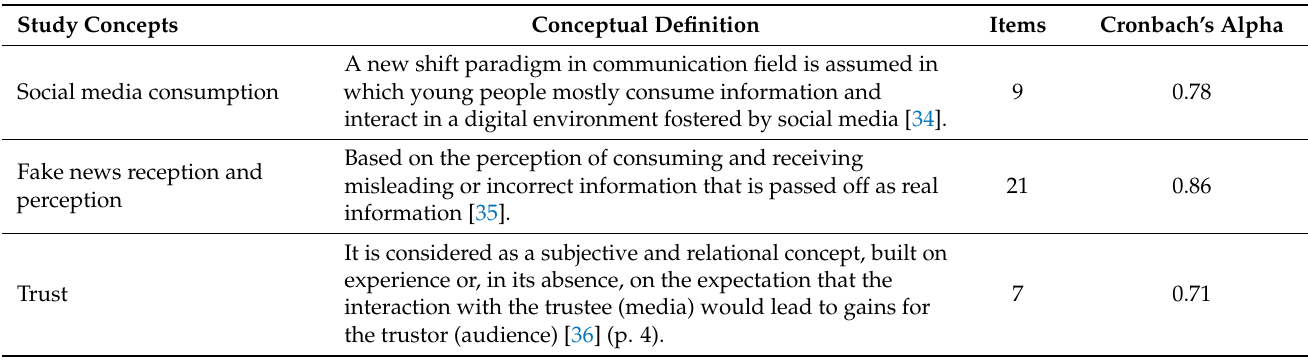
Table 1. Definition of the constructs under study and number of items